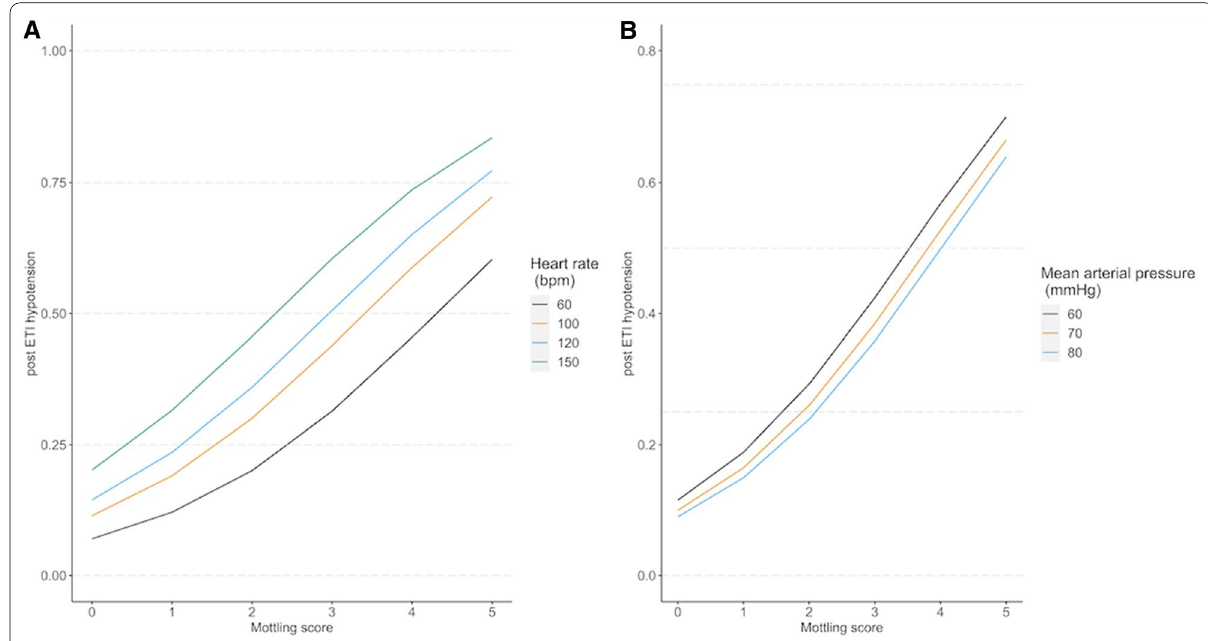
Fig. 1 Adjusted probability of PIHI by mottling score as a function of heart rate ( a ) and mean arterial pressure level ( b )